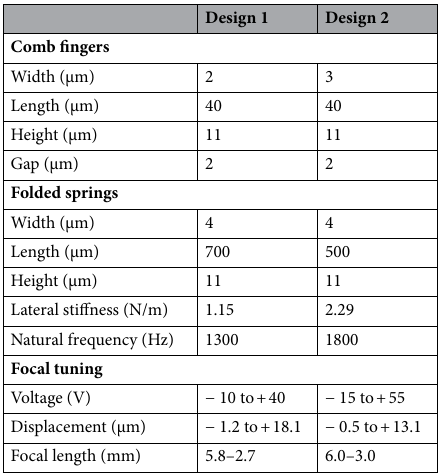
Table 1. Design parameters and performances of the MEMS Alvarez meta-optic lens. Device 2 images and results are presented in the Supplement